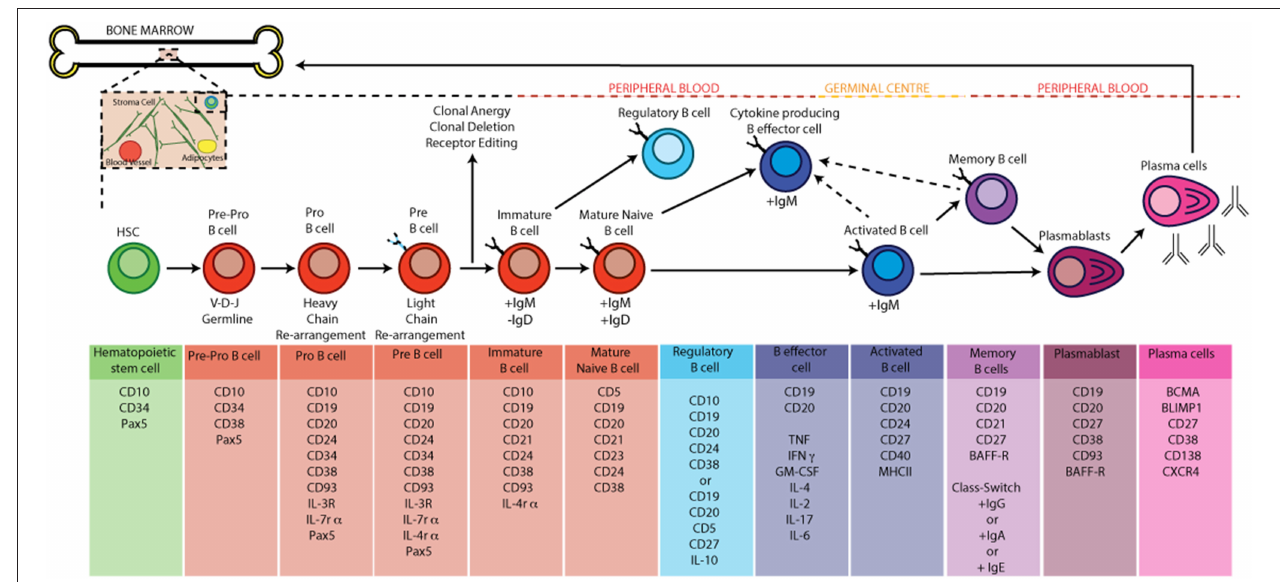
FIGURE 1 | B cell development and activation in humans . B cells develop from hematopoietic stem cells generated in the bone marrow. Pro-B cells express a unique antibody, the immunoglobulin (Ig) variable domain (Fv). They undergo re-arrangement of the heavy and light chains of this immunoglobulin (V-D-J and V-J recombination) leading to the development of pre-B cells. A pre-B cell acquires antigen specificity by the expression of a unique BCR and surface IgM as it matures into an immature B cell; at the this point the B cell under goes central tolerance by one of three processes: 1, receptor editing—immature B cells that react with low to high avidity self-antigens undergo receptor editing by a secondary rearrangement at the Ig κ or rearrangement of the Ig λ allele; 2, Clonal anergy—immature B cells that react with low avidity self-antigen can migrate to the spleen as anergic B cells; 3—clonal deletion: occurs at a low rate for those cells that fail receptor editing. If the immature B cell survives central tolerance they develop into mature antigen-inexperienced naïve B cells. In the germinal centre B cells mature into memory and plasma cells after antigen engagement. The GC produces memory and high affinity antibody-producing plasma B cells as a result of somatic hyper mutation, clonal expansion and class switch recombination (CSR). Terminally differentiated plasma cells migrate back to the bone marrow and memory B cells produce antibody when they encounter a secondary